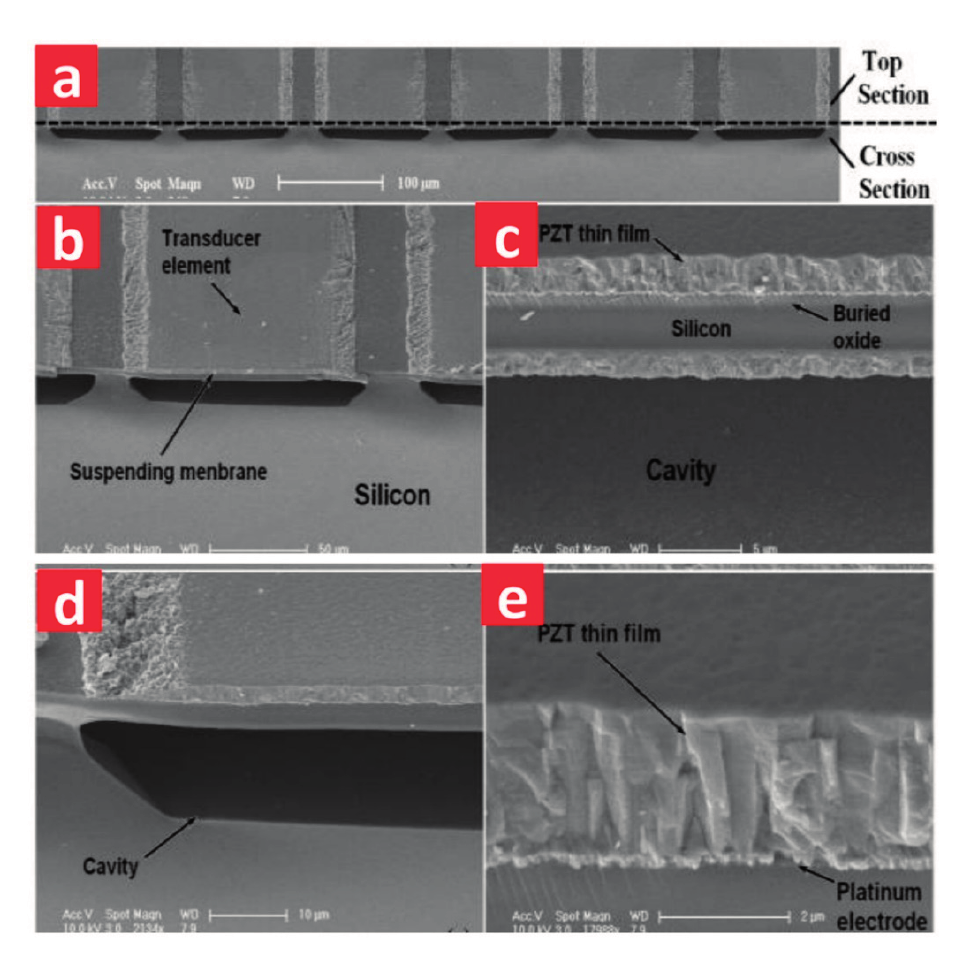
Figure 8. SEM images of ( a ) oblique view of the structure of PMUTs; ( b ) oblique view of a single PMUT element; ( c ) the suspended membrane stack; ( d ) oblique view of the cavity; and ( e ) the PZT thin film layer